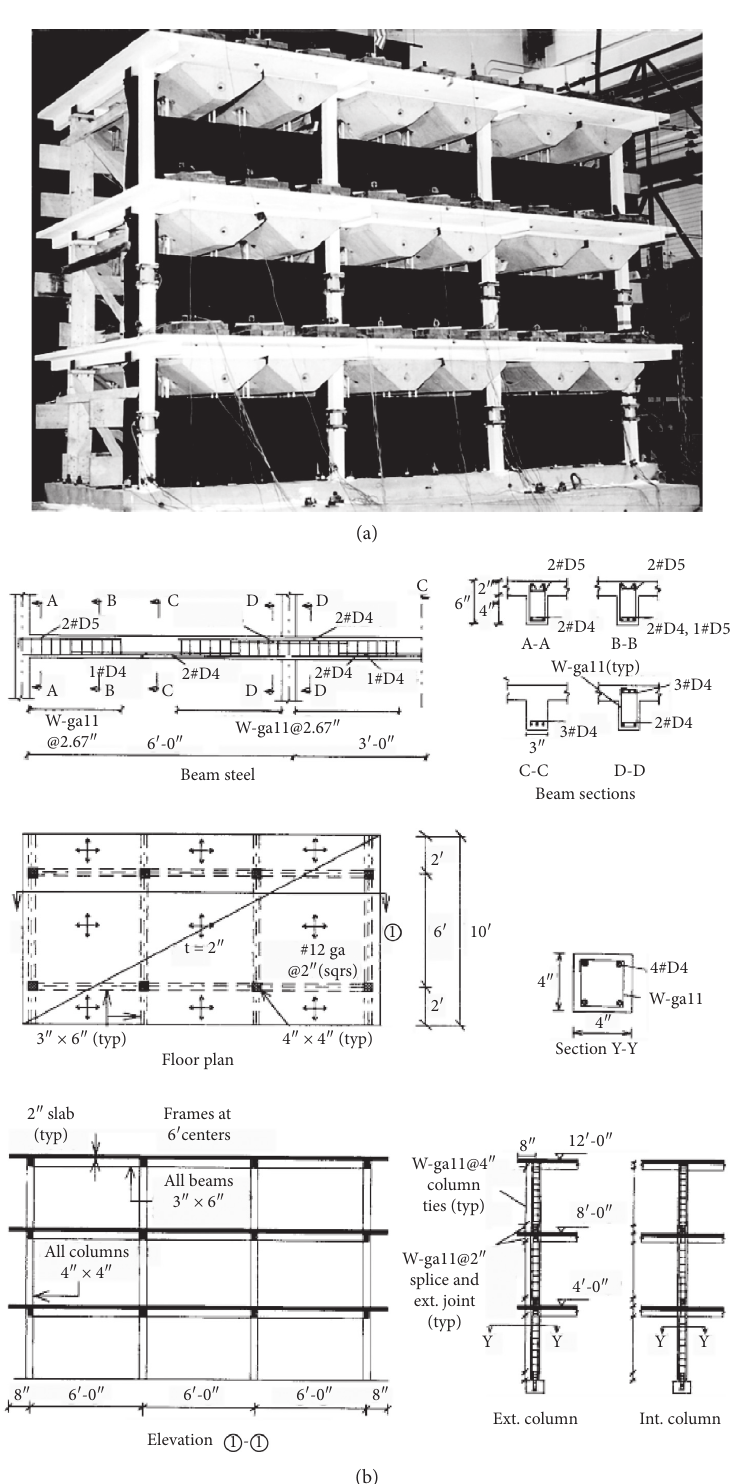
Figure 11: Three storey frame [75]. (a) General view. (b) Details (note: 1 in �